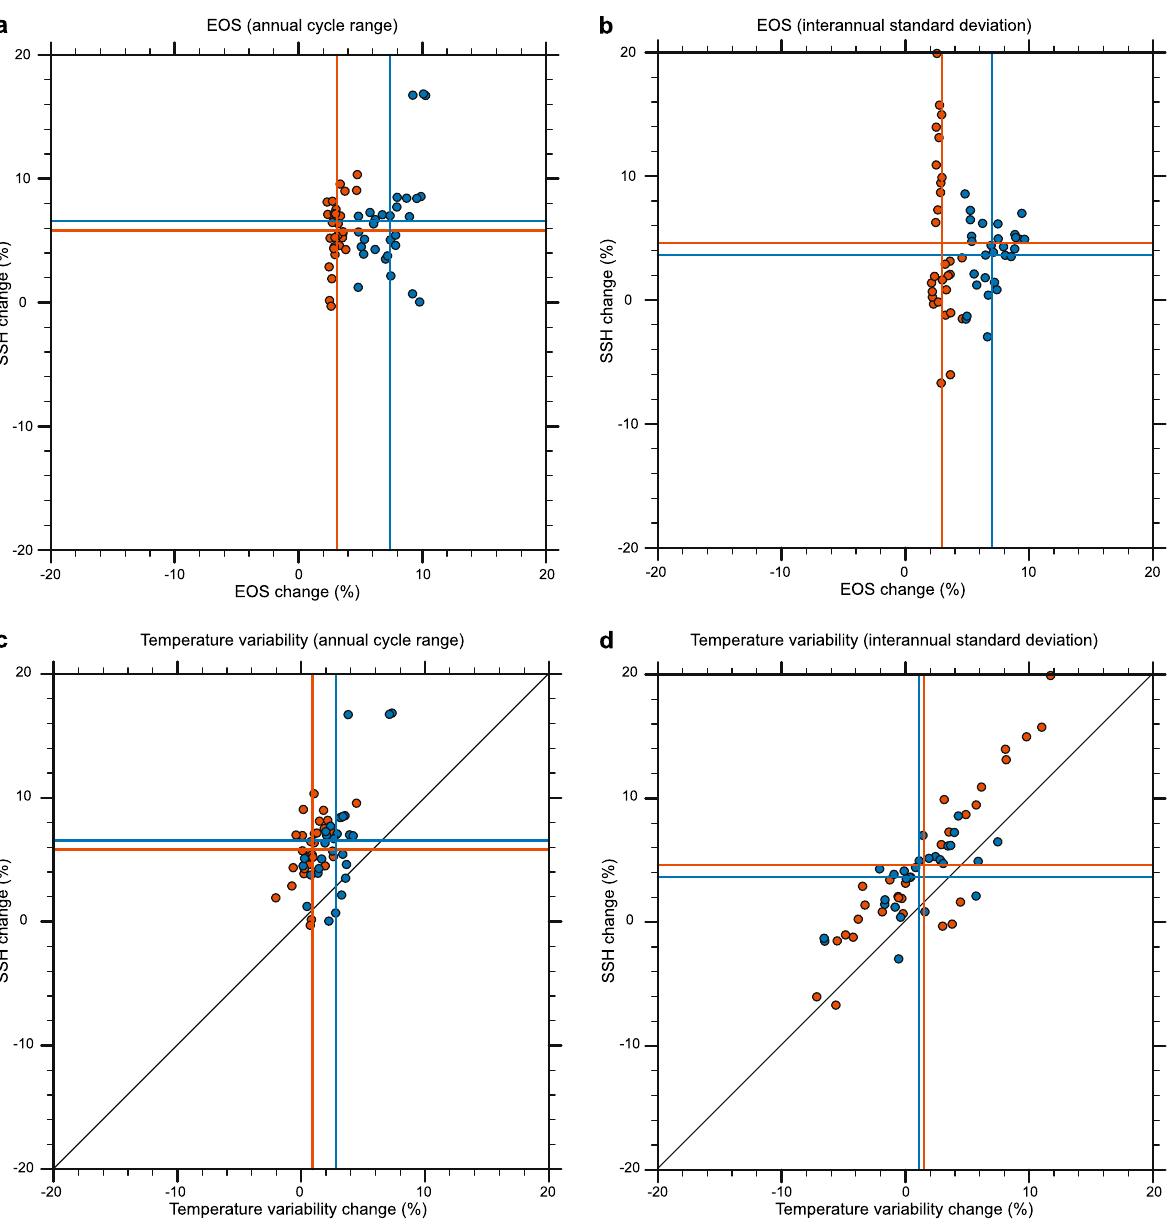
Fig. 5 Inter-model spread of future projected changes (%) of CMIP5 SSH related to the seawater EOS and ocean temperature variability. a , b Changes associated with the EOS of the annual cycle range and interannual standard deviation, respectively. c , d Similar respective changes associated with temperature variability. The distance of a point from the diagonal line is indicative of the change in SSH variability relative to temperature variability. a – d Changes are colored by latitude range (30°S – 30°N: orange; 30° – 60°N/S: blue). The multi-model mean changes for each region are indicated by the vertical and horizontal lines. Changes associated with the EOS and temperature variability components (x-axes) are scaled similarly to Fig. 4. Changes of sea level variability (y-axes) are for the CMIP5 SSH variable from the RCP8.5 experiment with respect to the historical